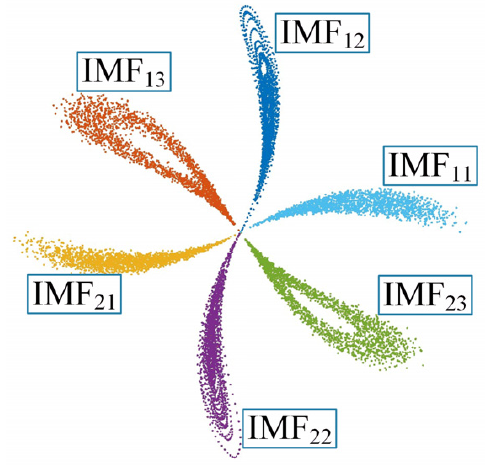
Figure 2. Principle of M-SDP.